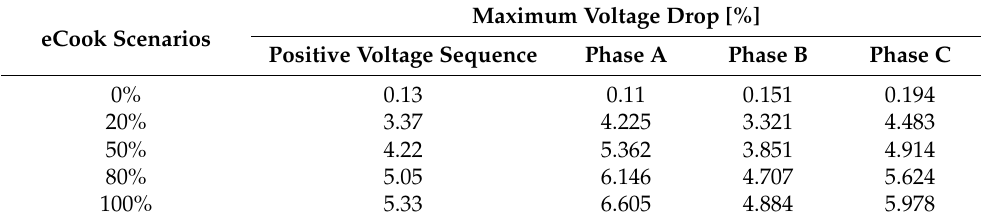
Table 2. Maximum voltage drops for different eCook penetrations.